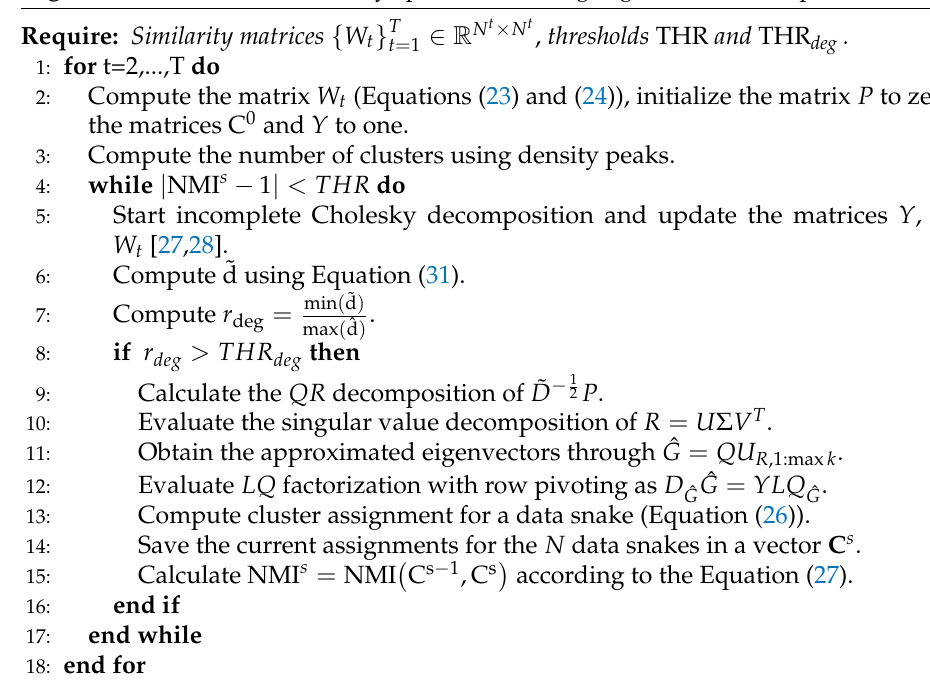
Algorithm 3 Efficient Evolutionary Spectral Clustering Algorithm for Transportation